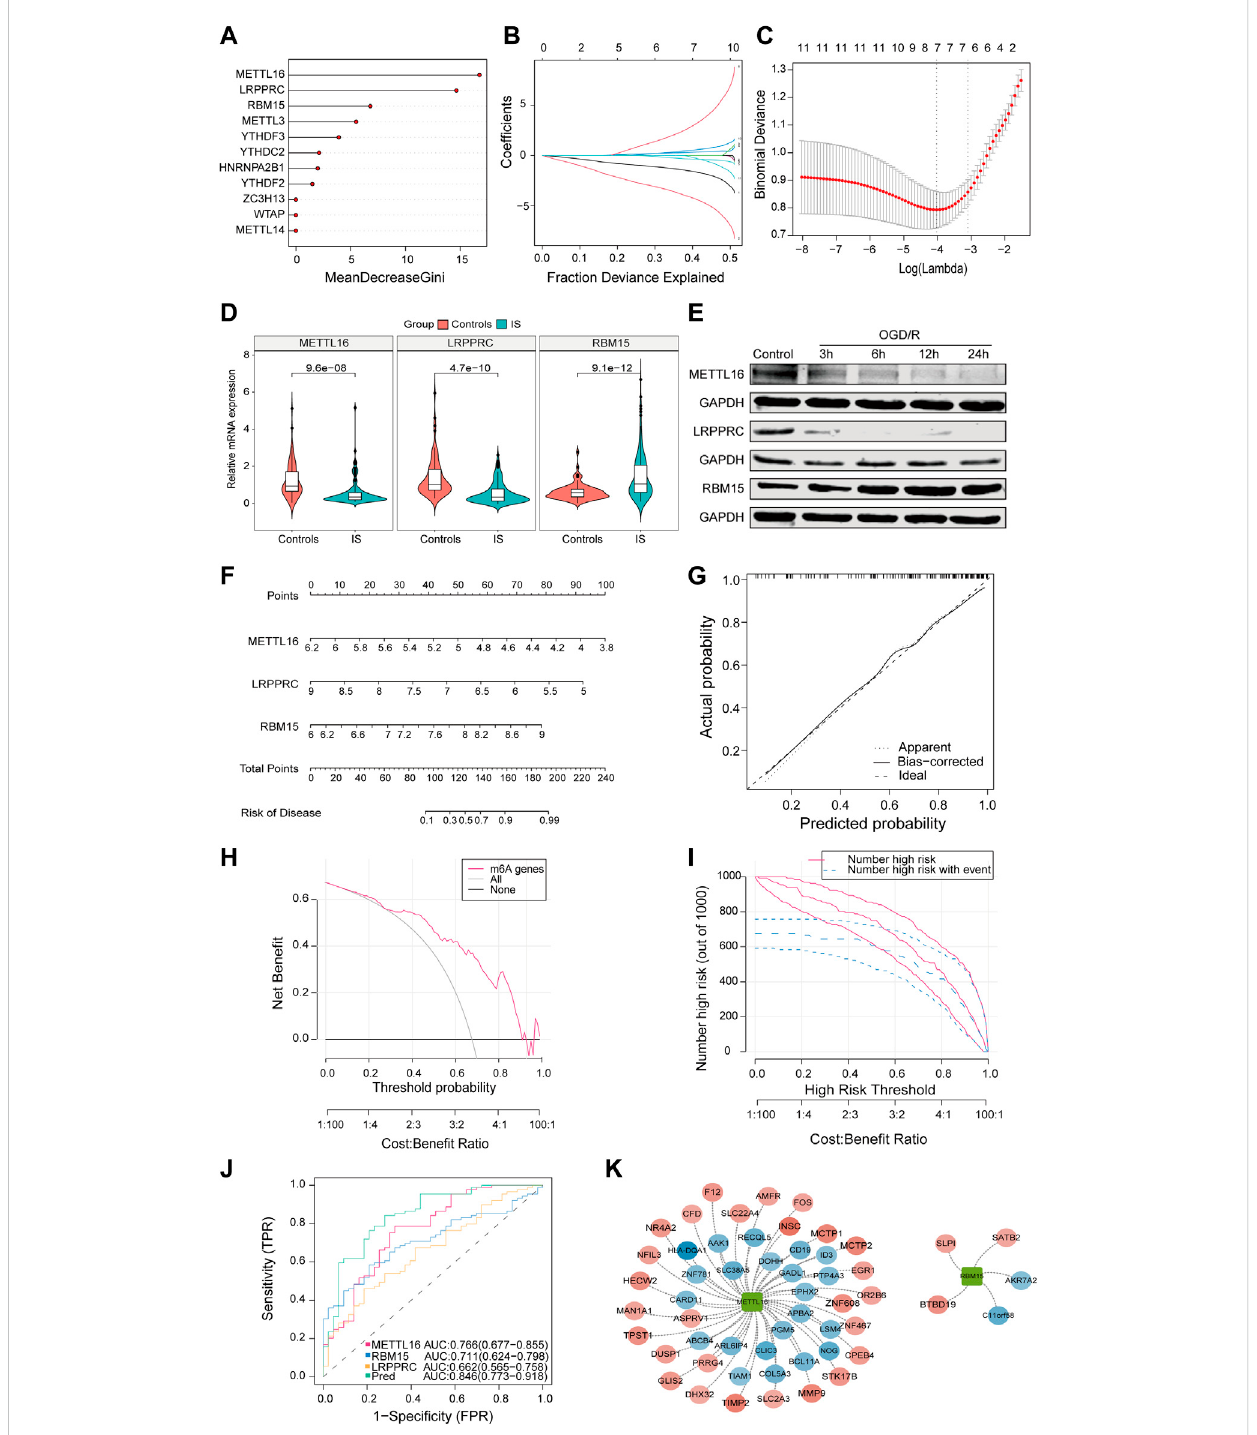
FIGURE 2 The characteristics of METTL16, LRPPRC, and RBM15 produced an ideal model with high accuracy. (A) The importance of the m6A regulators in the RF model. (B) LASSO coef fi cient pro fi les of m6A regulators. (C) LASSO regression tuning parameter selection using 10-fold cross-validation. (D) ExpressionofMETTL16( p =9.6*e − 8 ),LRPPRC( p =4.7*e − 10 )andRBM15( p =9.1*e − 12 )inclinicalsamples. (E) ExpressionofthreekeyregulatorsintheOGD/ R model. (F) The risk scores of 3 m6A regulators. (G) Predictive ability of the nomogram model as revealed by the calibration curve. (H) DCA curve indicating bene fi t with respect to IS samples. (I) Clinical impact of the nomogram model as assessed by the clinical impact curve. (J) The discrimination ability of the three crucial m6A regulators for controls and IS samples was analyzed by ROC curve analysis and evaluated by AUC values. (K) Validation of cross-talk of three crucial m6A regulators and targets by PPI network analysis. AUC: area under the